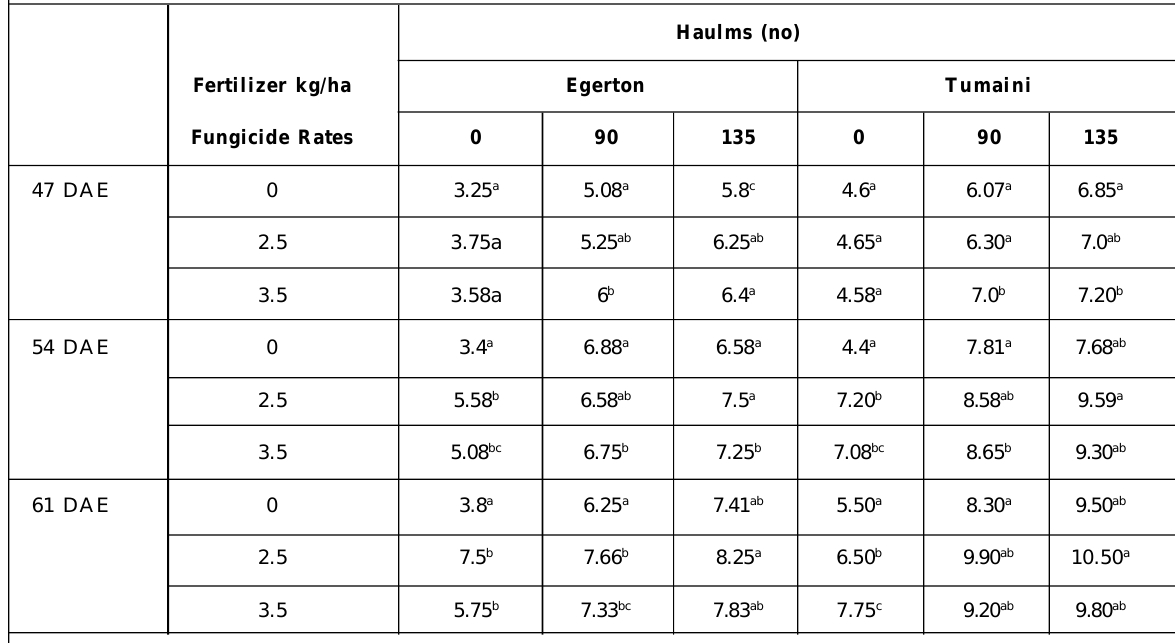
Table 4: The number of haulms as influenced by the interaction of fertilizer and fungicide Haulms (no) Fertilizer kg/ha Egerton Tumaini Fungicide Rates 0 90 135 0